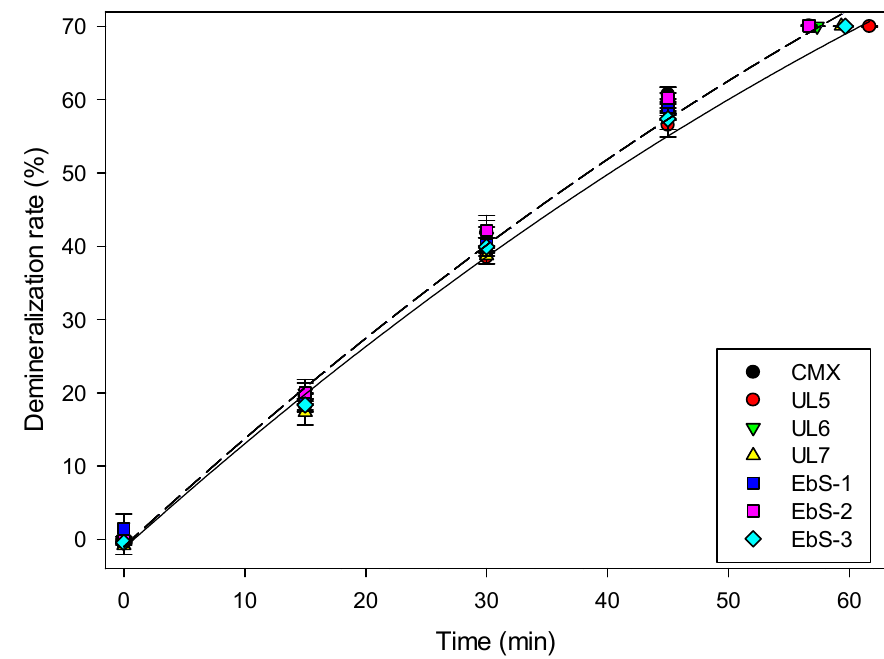
Figure 4. Whey demineralization as a function of time in ED using CMX or hCEMs.